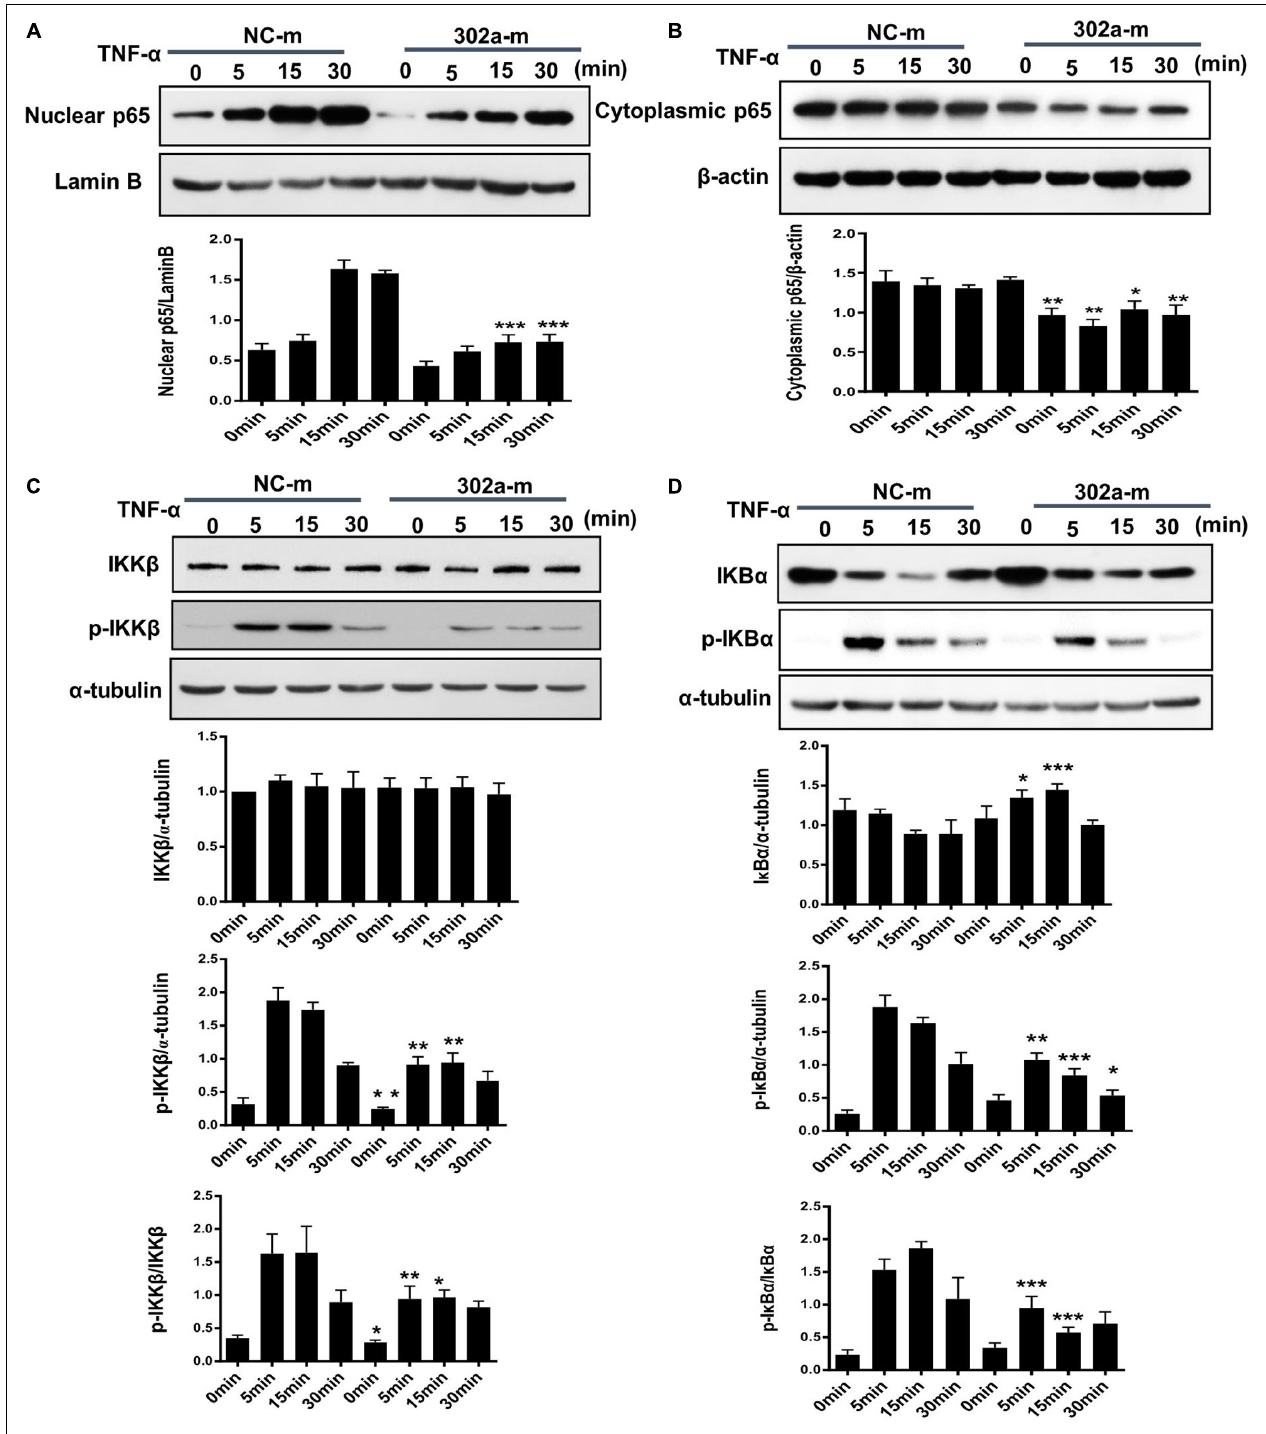
FIGURE 5 | MiR-302a inhibits nuclear translocation of nuclear factor kappa-B (NF- κ B) by the I κ B kinase complex β (IKK β )–inhibitors of κ B α (I κ B α ) pathway. HUVECs were transfected with 0, 25, 50, and 100 nM miR-302a-mimics/NC-mimics for 48 h and then treated with 10 ng/ml TNF- α for 0, 5, 15, and 30 min. The expression of p65 in nuclei (A) and cytoplasm (B) were examined by western blot, n = 5. (C) The degradation and phosphorylation of IKK β were examined by western blot, n = 5. (D) The degradation and phosphorylation of I κ B α were examined by western blot, n = 5 (* p < 0.05; ** p < 0.01; *** p < 0.001 vs. NC-m).